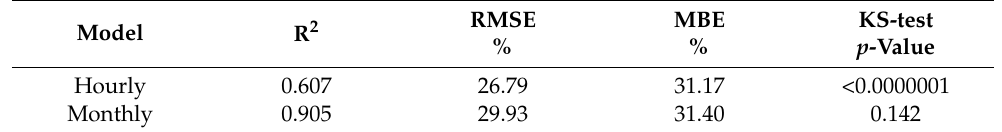
Table 4. Non-parametric validation for hourly and monthly irradiance